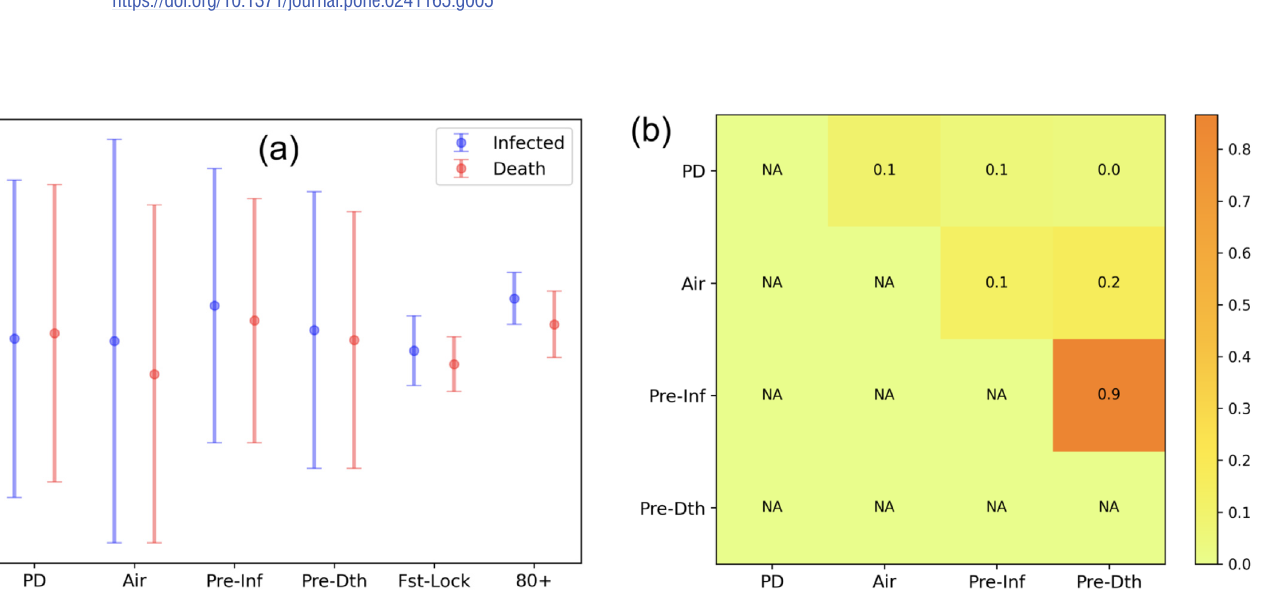
PLOS ONE | https://doi.org/10.1371/journal.pone.0241165 October 23, 2020 12 /